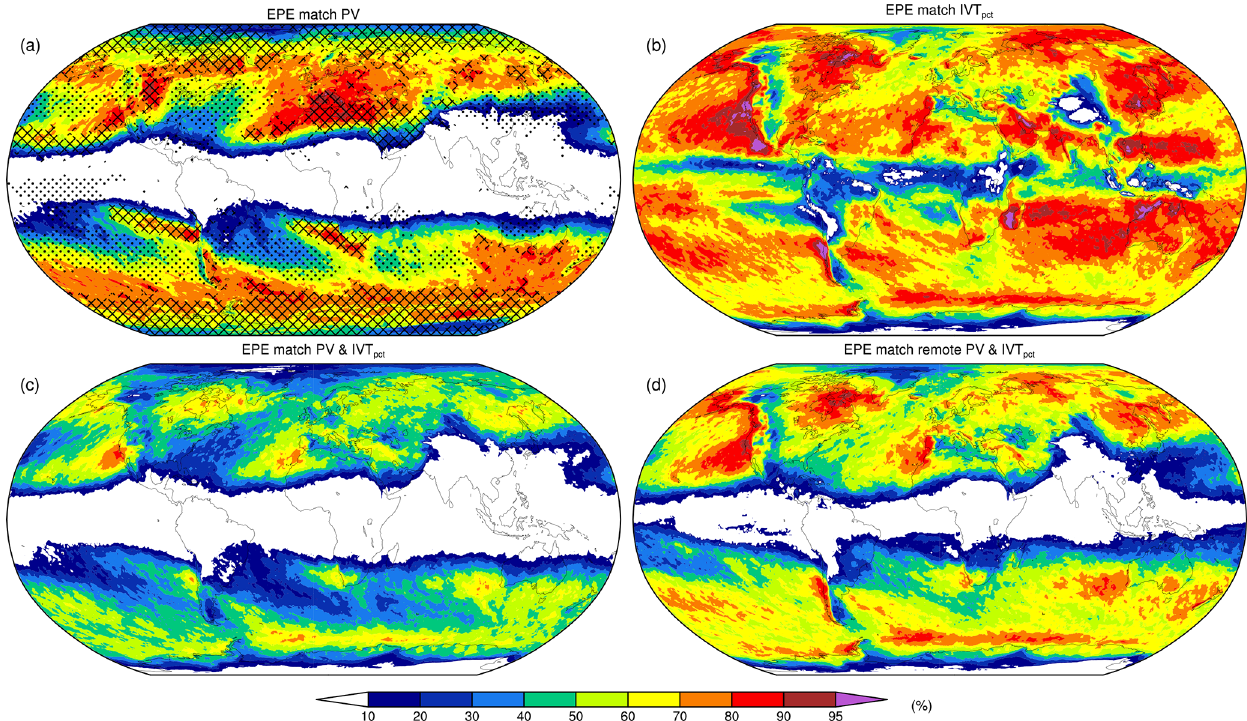
Figure 6. Fractions (%) of EPE matches with (a) PV structures, (b) IVT pct structures, (c) combined PV and IVT pct structures with a direct PV influence, and (d) combined PV and IVT pct structures which also allows a remote PV influence; see the text for details. The climatologies are based on the ERA-Interim period of 1979–2018. All matches that involve PV structures are based on isentropic surfaces between 300–350K with 5K intervals. In (a) the crossed hatching and stippling indicates statistically significant fractions that are larger and smaller, respectively, than expected under independence of EPEs and PV structures (see the text for details), whereas in (b–d) only statistically significant fractions are plotted that are larger than expected under independence of EPEs and the